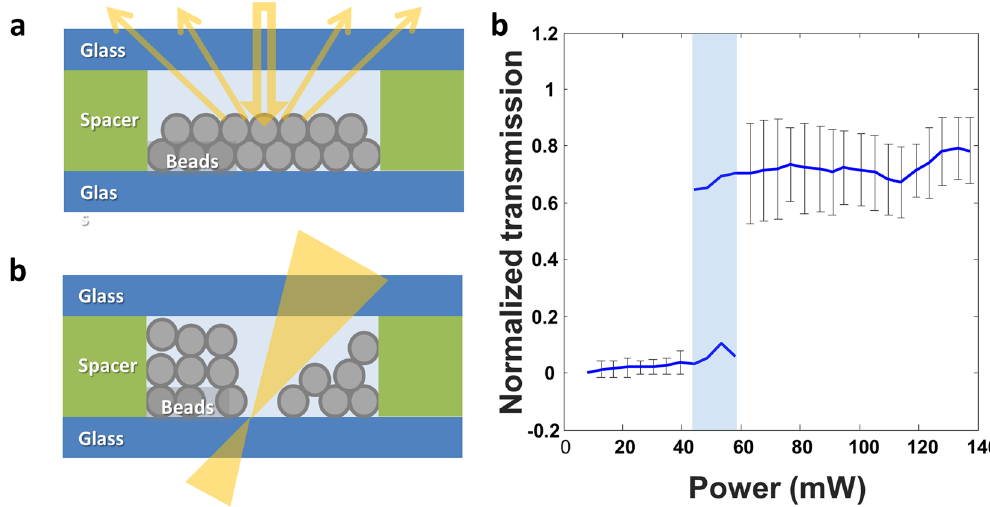
Figure 5. Disordered reactive optical element. ( a ) Dense collection of microparticles blocks transmission by reflecting and absorbing the incoming light at mild to low intensities. ( b ) Above a critical power level of the incoming light, the OMF removes the particles out of the beam path such that transparency emerges. ( c ) Transmission of the disordered optical substance as a function of incoming laser power. The critical power beyond which transparency arises is marked in Methods Sample preparation. The sample was made from glass microspheres that are coated with a thin (200 nm) layer of silver (SLGMS-AG-2.5 from Cospheric, USA). The diameter of a typical sphere (micro-sphere) that was